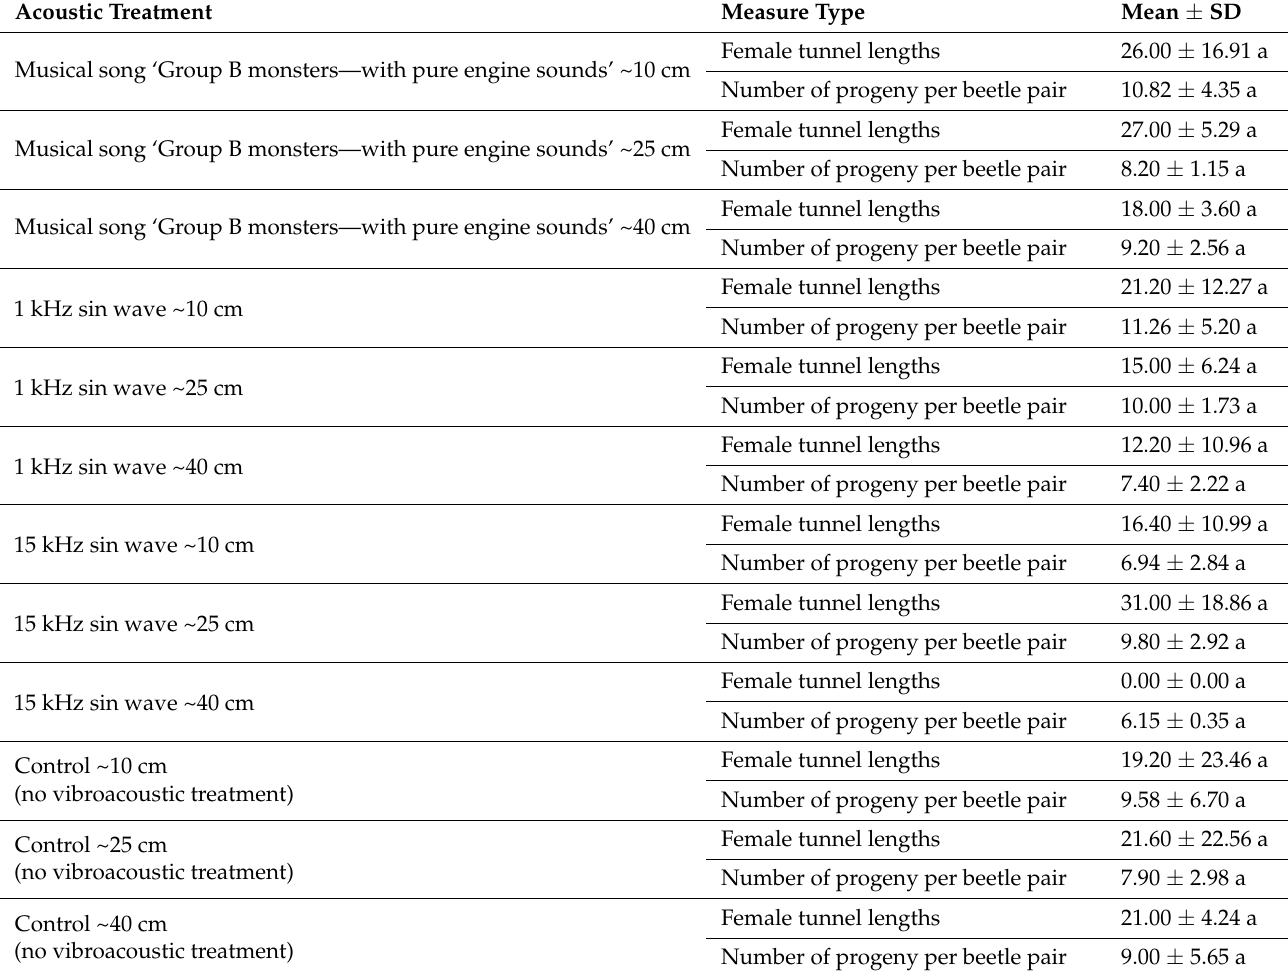
Table A3. Post hoc statistical analysis (multiple comparisons of mean rank tests) of measured variables (means ± SD) between acoustic treatments. Letter “a” represents a statistically not significant difference between acoustic treatment groups or lengths on the log (female tunnel lengths: Kruskal–Wallis ANOVA–H (11) = 8.89, p = 0.631; number of progeny per beetle pair: Kruskal–Wallis ANOVA–H (11) = 10.84, p =